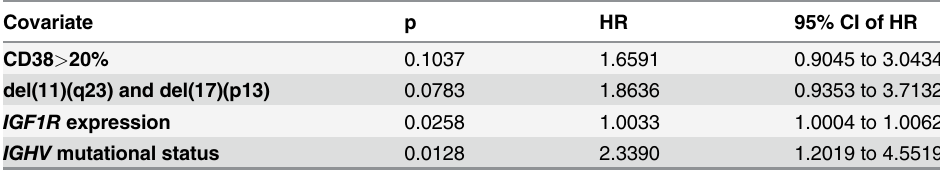
Table 2. Cox multivariate analysis results considering only CLL